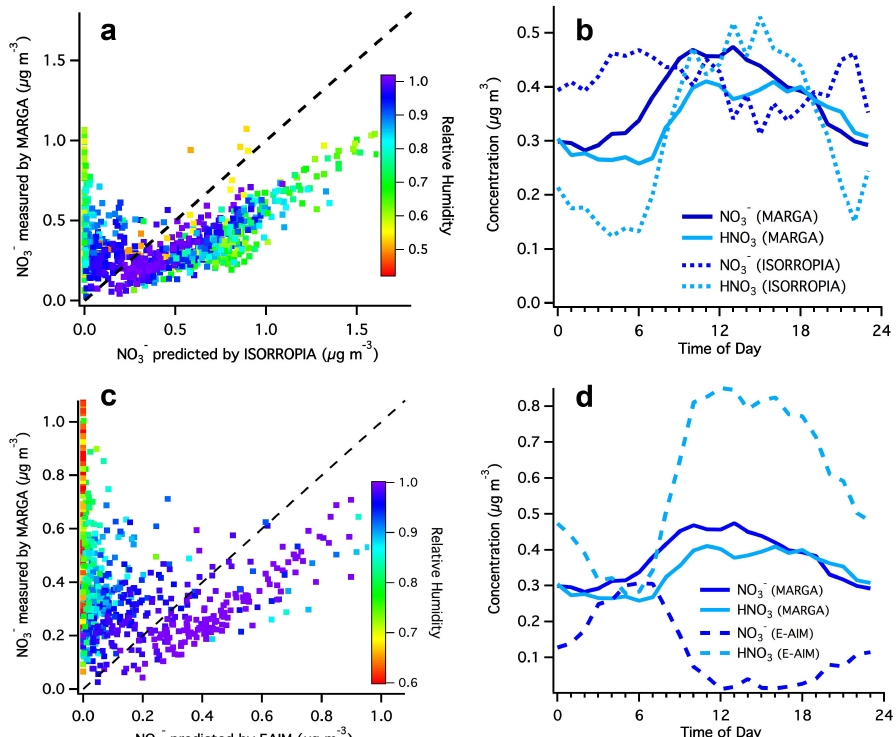
Figure 7. Results of inorganic modeling compared with measurements made by MARGA during the 2013 SOAS campaign. (a) Correlation of hourly aerosol NO − concentrations predicted by ISORROPIA II and measured by MARGA; (b) Diurnal pattern, averaged over the 3 duration of the campaign, of gaseous HNO 3 and aerosol NO − for ISORROPIA II and MARGA; (c) Correlation of hourly aerosol NO − 3 concentrations predicted by E-AIM and measured by MARGA; and (d) Diurnal pattern, averaged over the duration of the campaign, of gaseous HNO 3 and aerosol NO − for E-AIM and 3